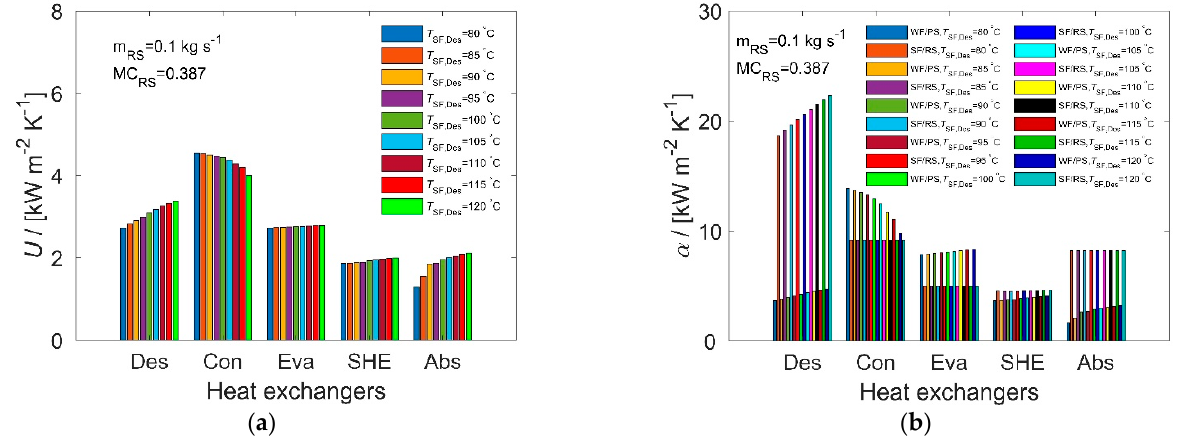
Figure 9. Overall HTCs ( a ) and two sides HTCs ( b ) of the heat exchangers for the rich solutions of 0.1 kg s − 1 and mass concentration 0.387. For Des, Con, Eva and Abs, the two sides are working fluid (WF) and secondary fluid (SF). For SHE, the two sides are poor solution (PS) and rich solution (RS).